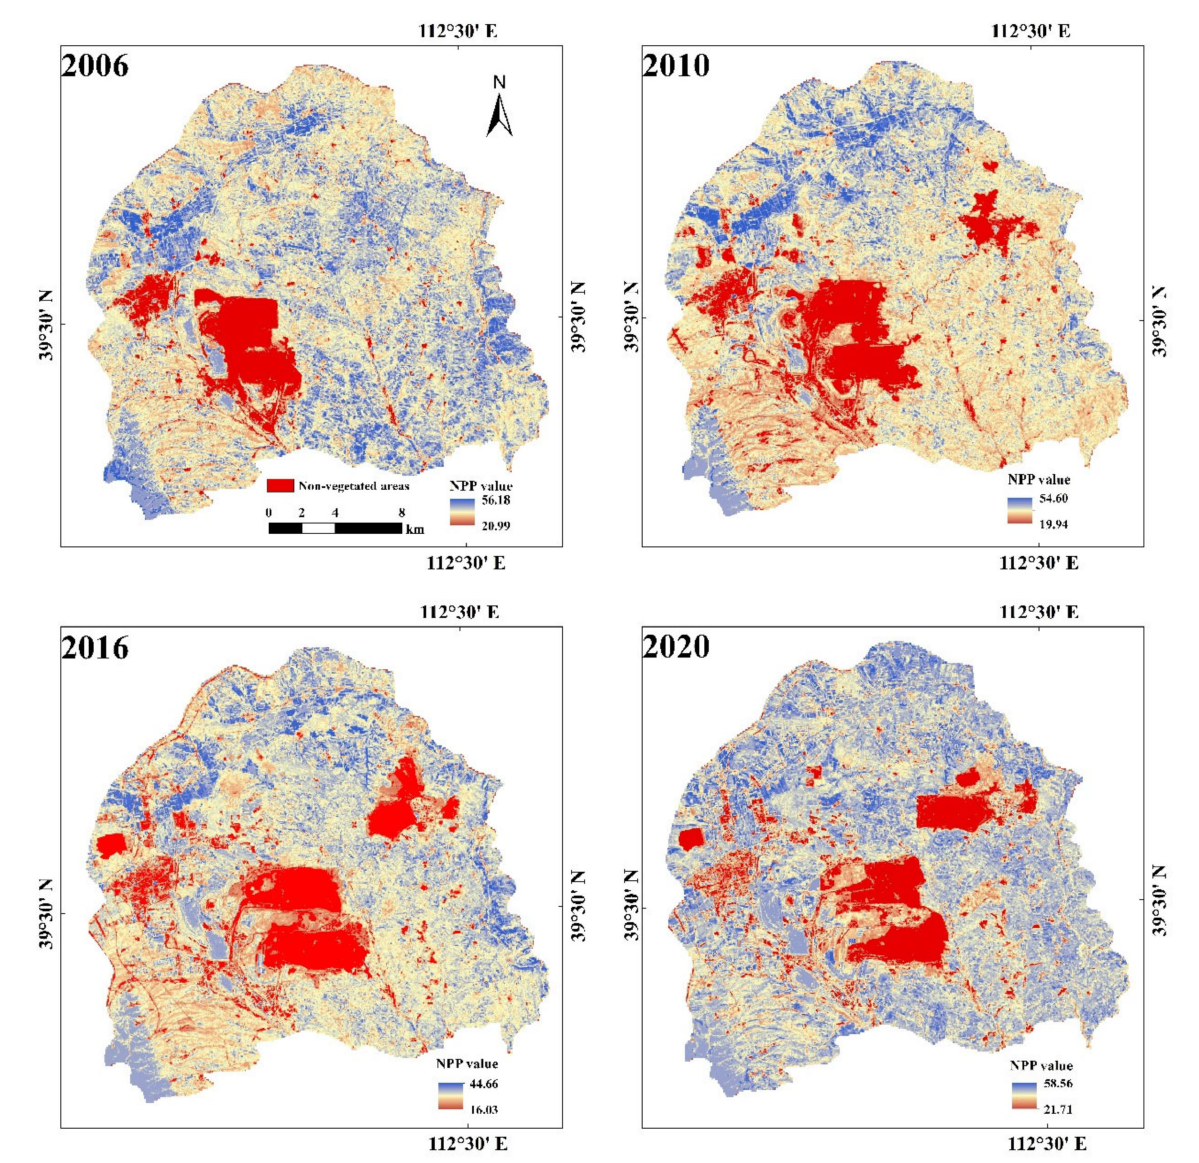
Figure 3. Distribution of net primary productivity (NPP) of vegetation in different